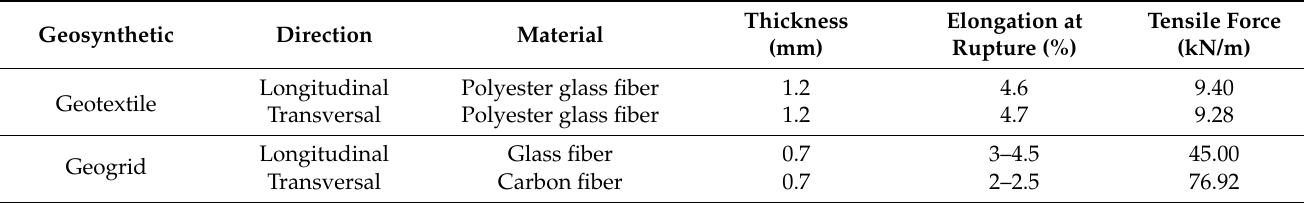
Table 1. Characteristics of